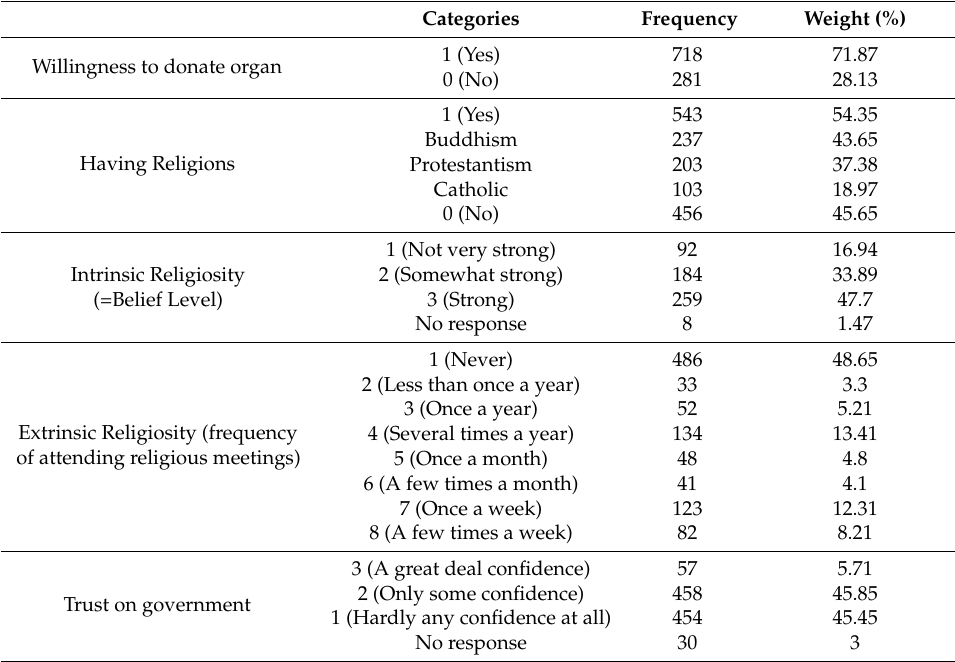
Table 1. Distribution of survey sample ( N = 999).